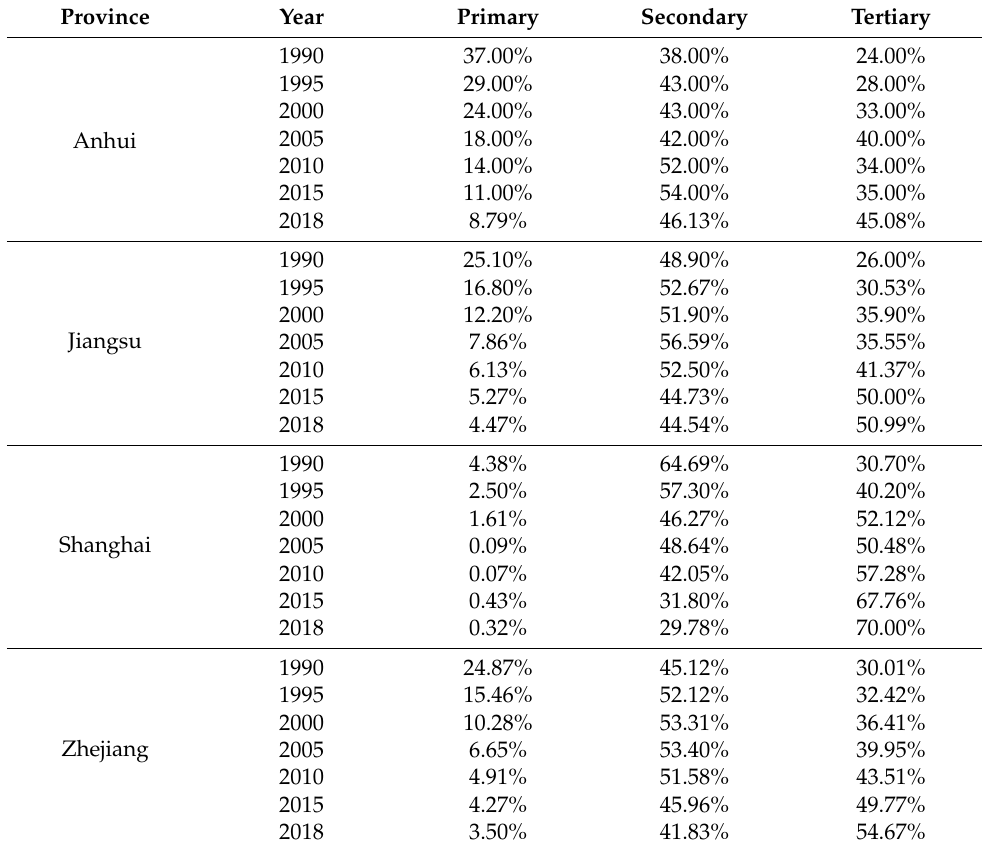
Figure 6. Change curves of the industrial structure of the Yangtze River Delta Urban agglomeration. Table 7. Industrial structure of the Yangtze River Delta (source: http://www.stats.gov.cn/ accessed on 15 October 2022).